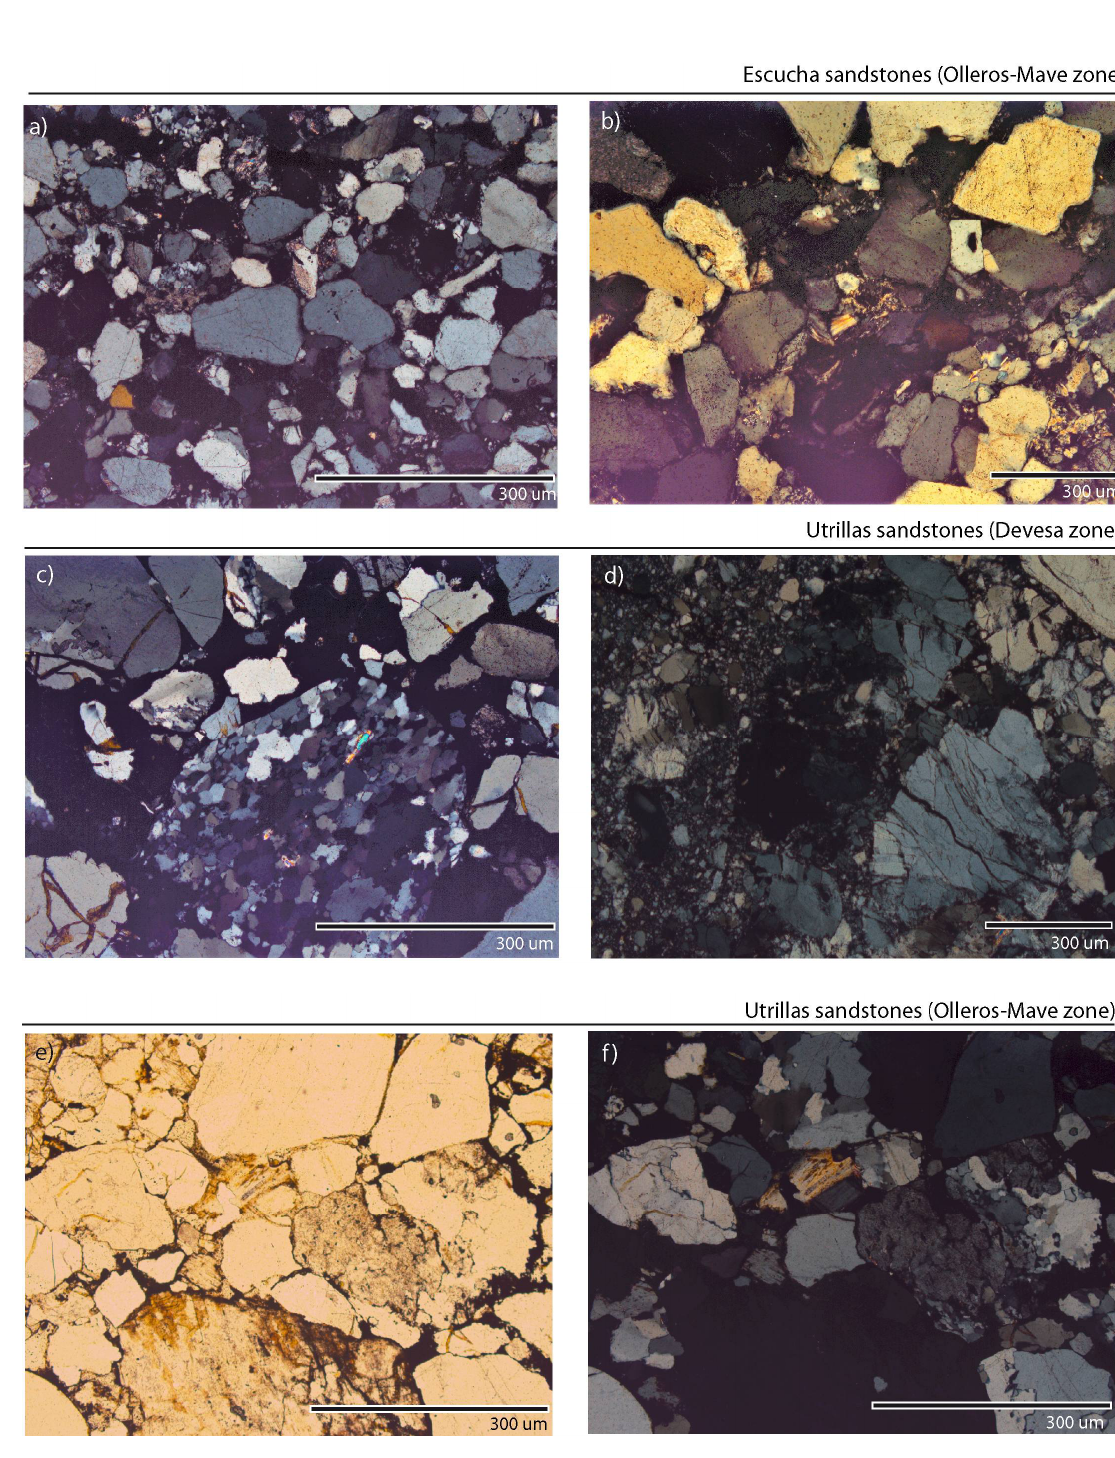
Figure 4. Characteristic textural features of the detrital rocks observed by OpM. ( a ) Homogeneous grain size and dominantly quartz composition of the Escucha sandstones (Mave site) with a tourmaline crystal. Crossed nicols, 5×. ( b ) Quartz, feldspar and phyllosilicate components in the Escucha sandstones (Mave site). Crossed nicols, 10×. ( c ) Mono- and polycrystalline quarts grains of highly heterogeneous size in the Utrillas sandstones (Devesa site). Crossed nicols, 5×. ( d ) Quartz in the Utrillas sandstones (Devesa site). Crossed nicols, 5×. ( e , f ) Significant Fe-oxide, -hydroxide content in the matrix of the Utrillas sandstone (Olleros site). Crossed and parallel nicols, 5×.